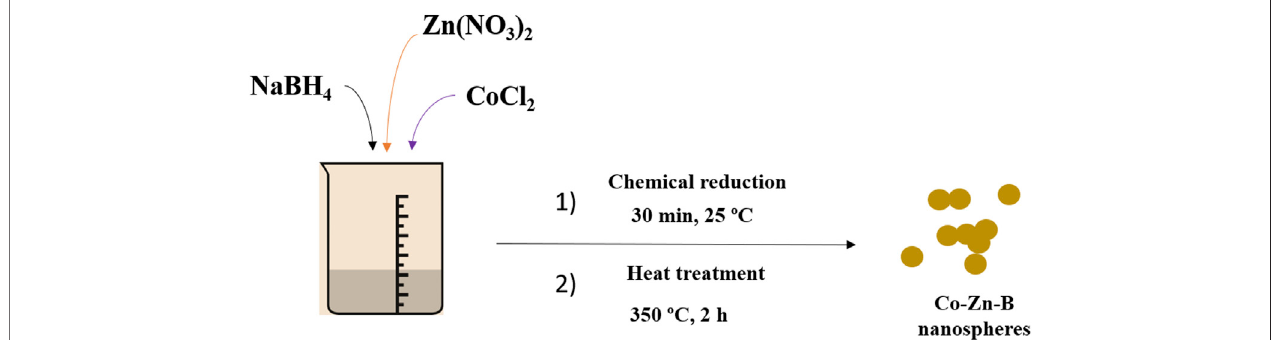
FIGURE 1 | Illustration of the synthesis process of Co-Zn-B.